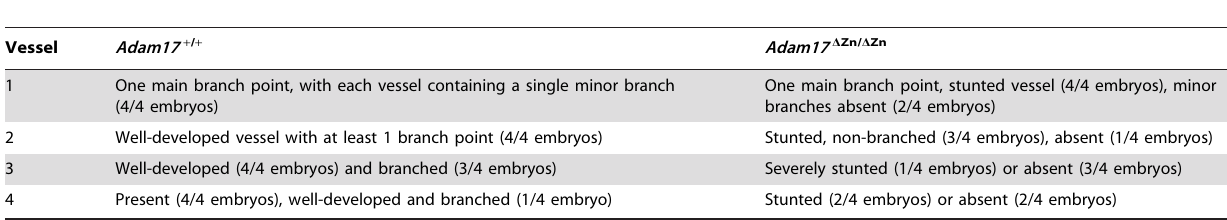
Table 2. Descriptive Summary of the Adam17 D Zn/ D Zn Cranial Vasculature Phenotypes.